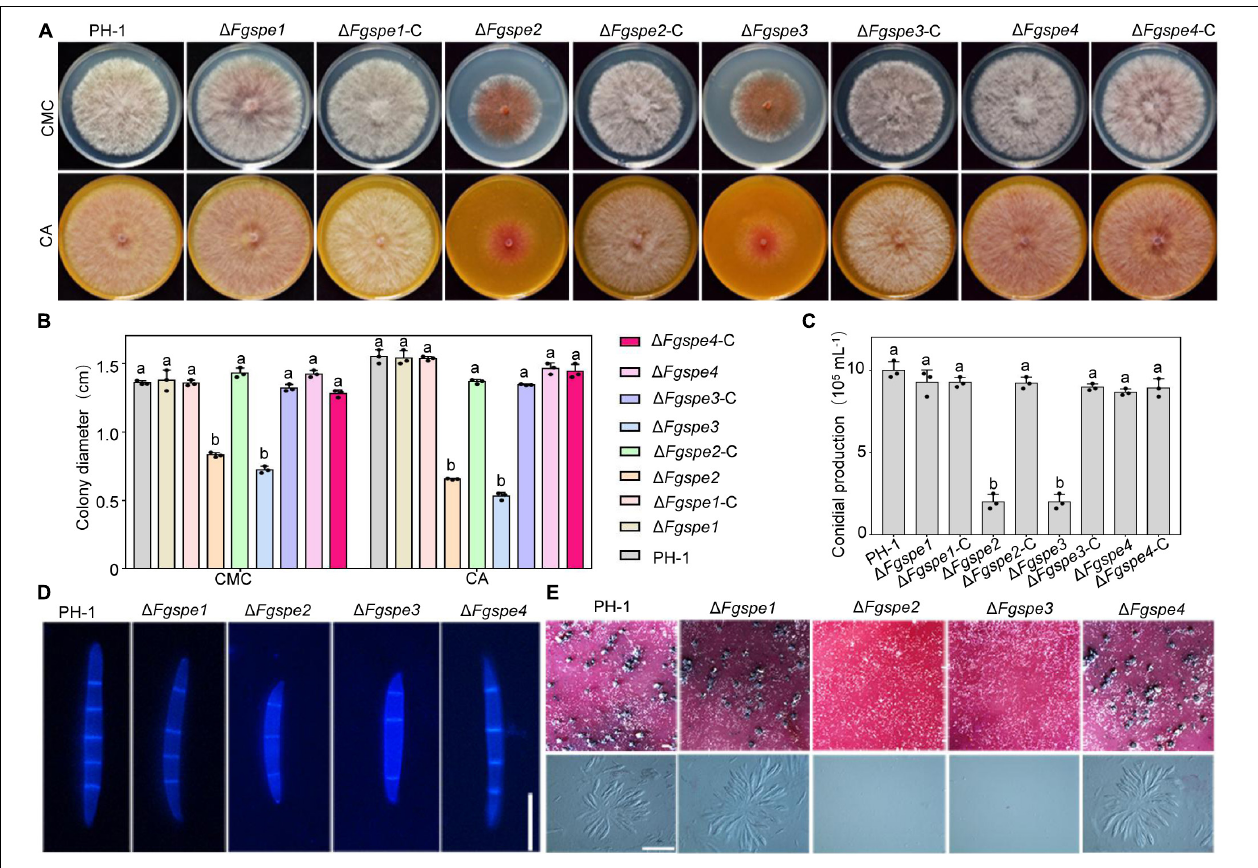
FIGURE 4 | Spermidine is important for asexual and sexual reproduction. (A) Colony morphology of PH-1, deletion mutants, and complementation mutants on CMC and CA agar medium. (B) The growth rate of mutants after 3 days were analyzed. Columns listed with the same letter are not significantly different at P = 0.05. (C) The number of conidia produced by each strain in CMC medium for 4 days. (D) Conidial morphology of wild-type and (cid:49) Fgspe mutants strains. The septa were stained by Calcofluor White and photographed by a fluorescence microscope. Bar, 50 µ m. (E) Typical perithecia (upper panel), asci, and ascospores (bottom panel) formed by PH-1 and (cid:49) Fgspe mutants on CA. Photographs were recorded after incubation for 3 weeks. Bar, 200 µ